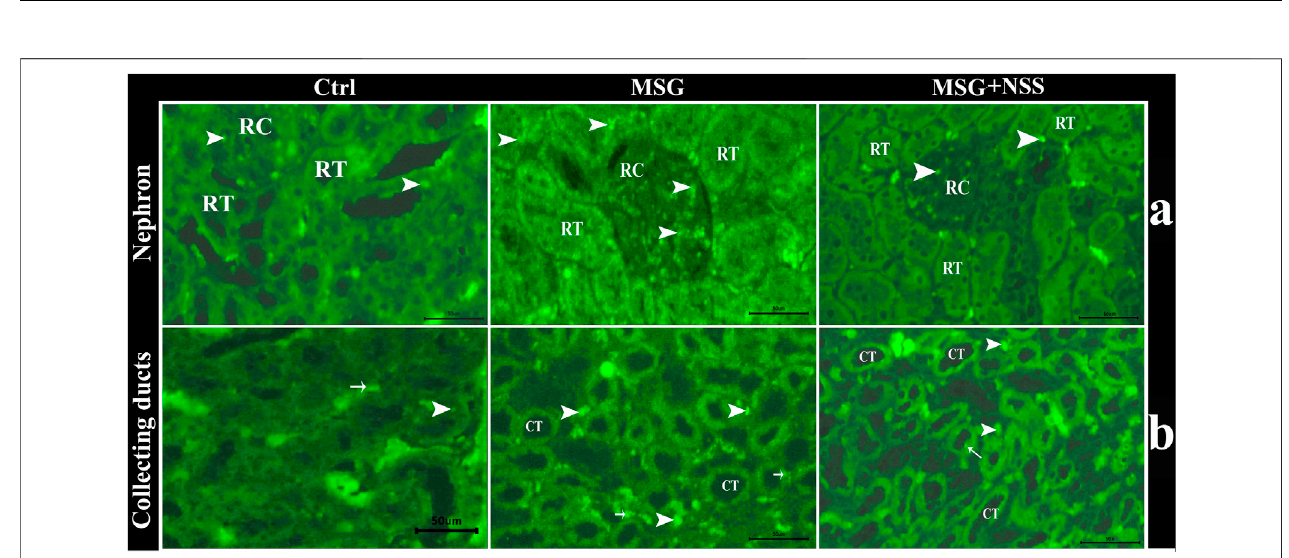
FIGURE 4 | Fluorescent photomicrograph of TUNEL assay in paraf fi n sections in kidney. showing the protective effect of NSS on MSG induced renal damage. (A) renal cortex incontrol group (Ctrl) showedfew number ofapoptotic cells(arrowhead)in renalcorpuscles (RC) and renal tubules (RT), renal cortex inMSGgroup showed high number ofapoptotic cells (arrowheads) inRCand RT, and renalcortex in MSG+NSS groupshowedfew number ofapoptotic cells(arrowheads)in RCand RT. (B) Renal medulla in control group (Ctrl) showed few number of apoptotic cells in the collecting ducts (arrow) and in the interstitial tissue (arrowheads), renal medulla in MSG group showed highnumber ofapoptotic cells inthecollectingducts (arrows) and inthe interstitialtissue(arrowheads),renal medullain MSG+NSS group showed few number of apoptotic cells in the collecting ducts (arrow) and in the interstitial tissue (arrowheads). Scale bars = 50 μ m.